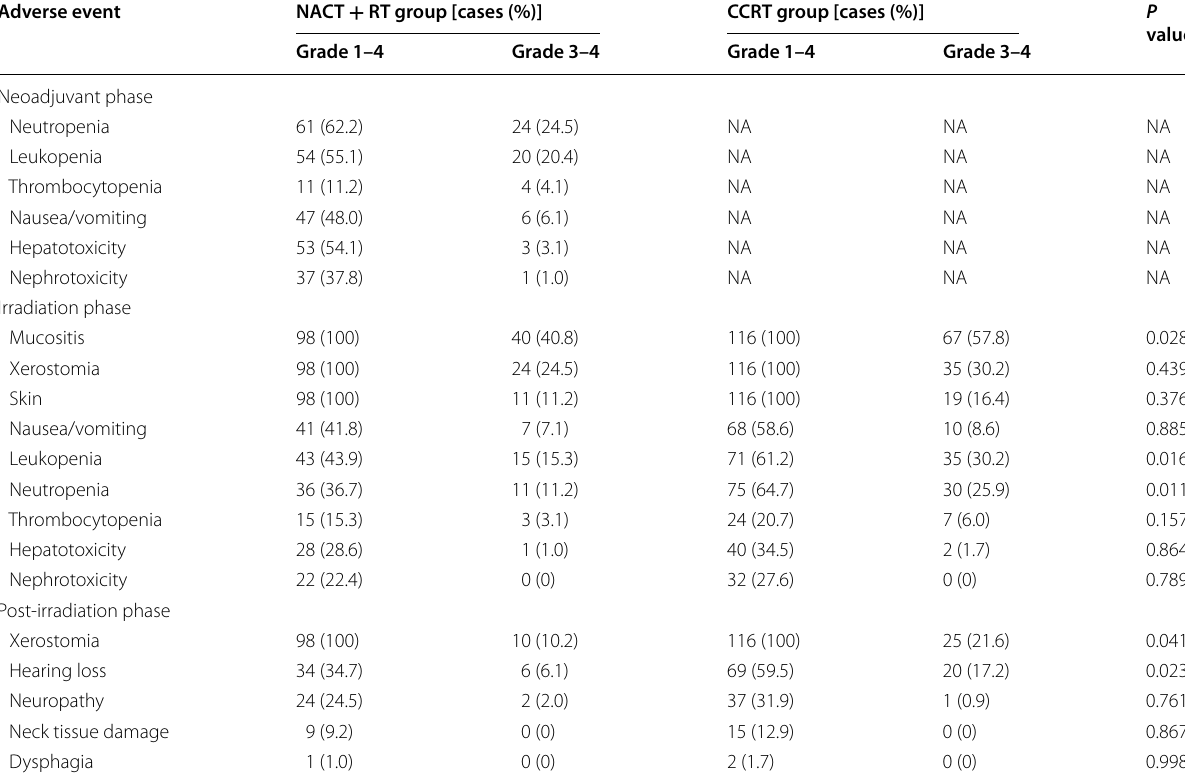
RT and CCRT groups +